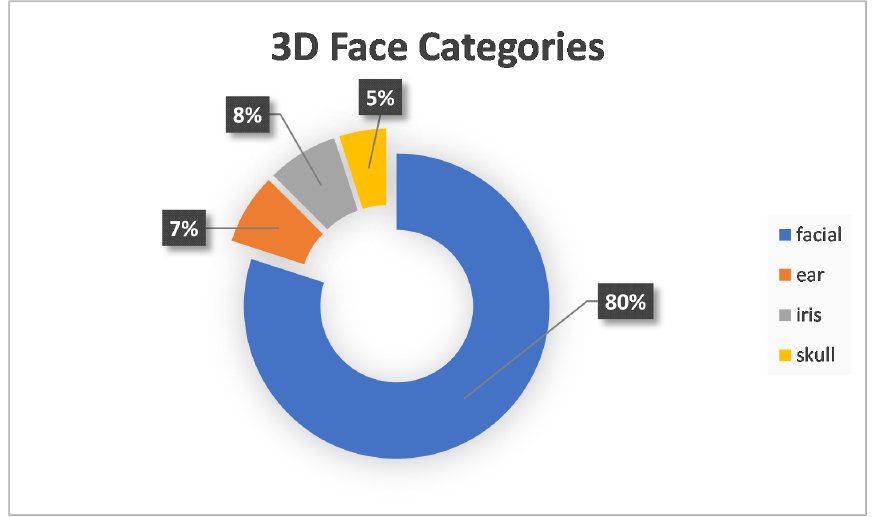
Figure 4. Three-Dimensional (3D) Face